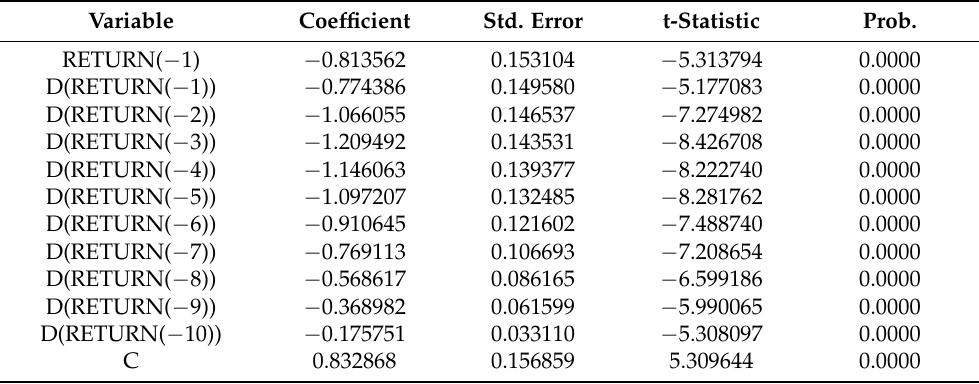
Table 2. Augmented Dickey-Fuller test